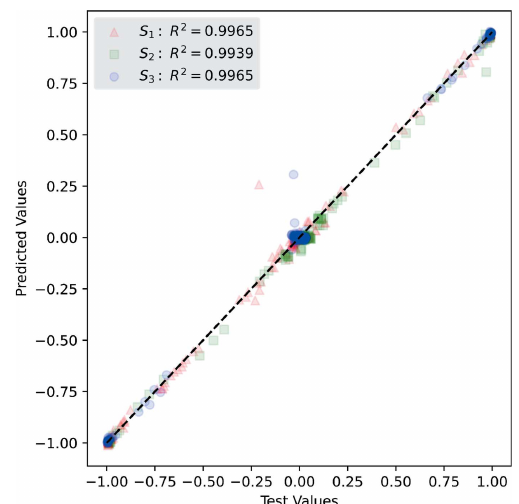
Figure 8 Comparison between predicted and test output Stokes parameters for measured data from the NN. Excellent agreement is shown for the majority of test cases except for the E45:L45 case (predicted S 1 value of (cid:9) 0.26 versus a test value of (cid:9)(cid:2) 0.21; predicted S 2 value of (cid:9) 0.8 versus a test value of (cid:9) 0.97; predicted S 3 value of (cid:9) 0.31 versus a test value of (cid:9)